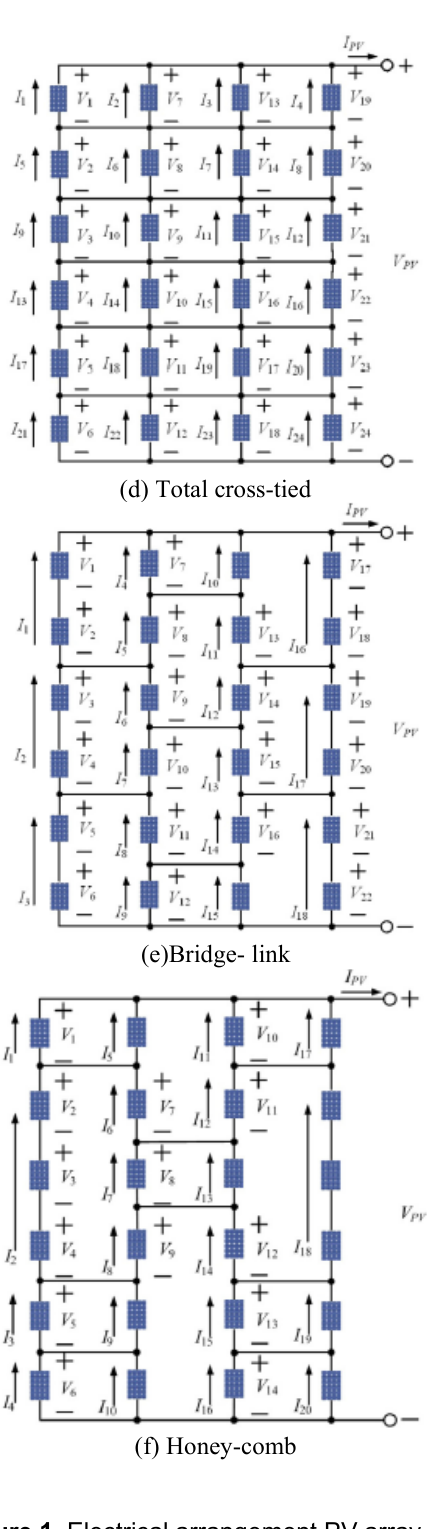
Figure 1. Electrical arrangement PV